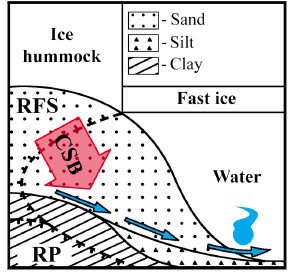
Figure 16. Scheme of CSB and expulsion of water-soluble salts from the ice formation zone into warmer, unfrozen parts of the sed- iments. RFS – recently frozen soil. RP – relict